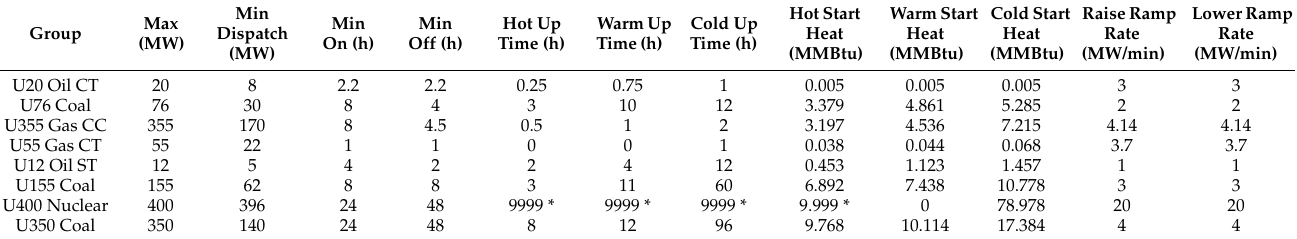
Table A1. Generator data summary of the characteristics of the thermal fleet in the RTS-GMLC